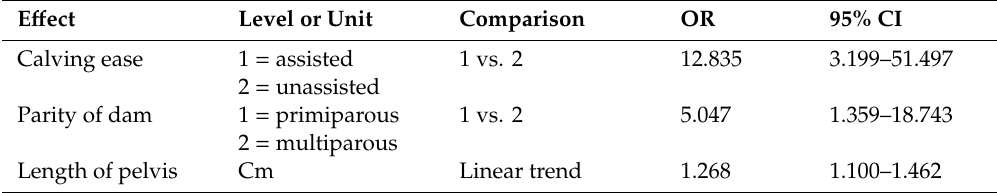
Table 8. Odds ratio estimates for e ff ects in the logistic regression model for perinatal